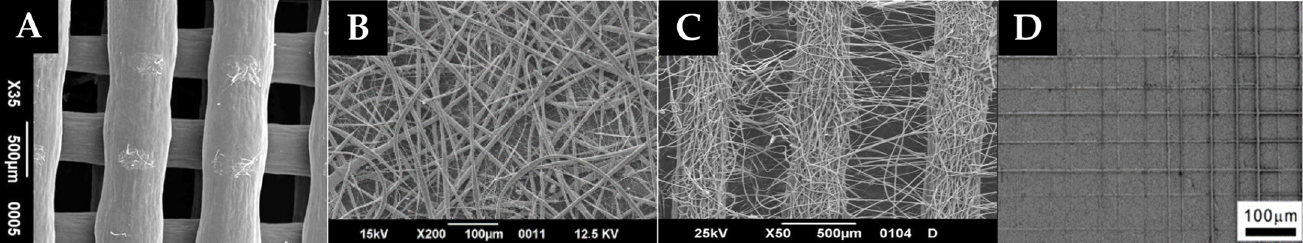
Figure 1. Scanning electron microscope images of: ( A ) Scaffold printed by FDM, ( B ) Scaffold printed by electrospinning, ( C ) Scaffold printed by hybrid technique (FDM + Electrospinning), ( D ) Scaffold printed by MEW. This figure is based on work by Sabino, M.A. et al. 2017 [3], licensed under CC BY 4.0.